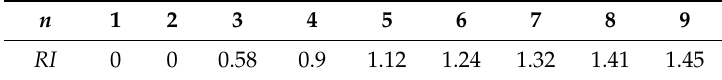
Table 9. Average random